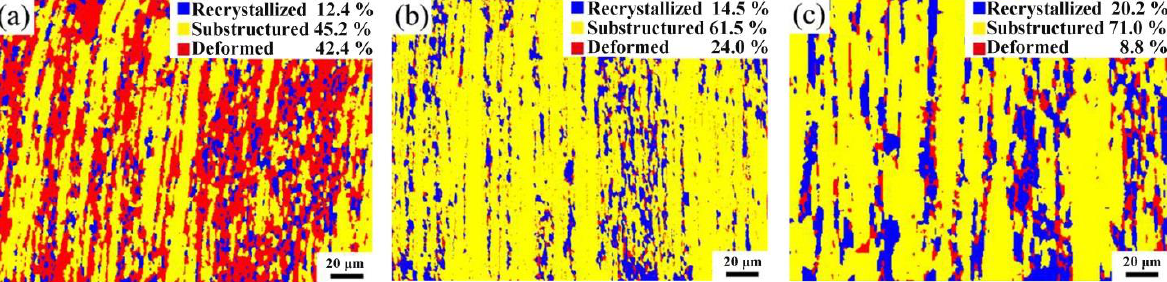
Figure 14. Distribution of recrystallized grains, sub-crystal structure and deformed structure in the EBSD maps of samples under different conditions: ( a ) 0.1 s − 1 , 673 K, ( b ) 1 s − 1 , 673 K, ( c ) 10 s − 1 , 673 K.